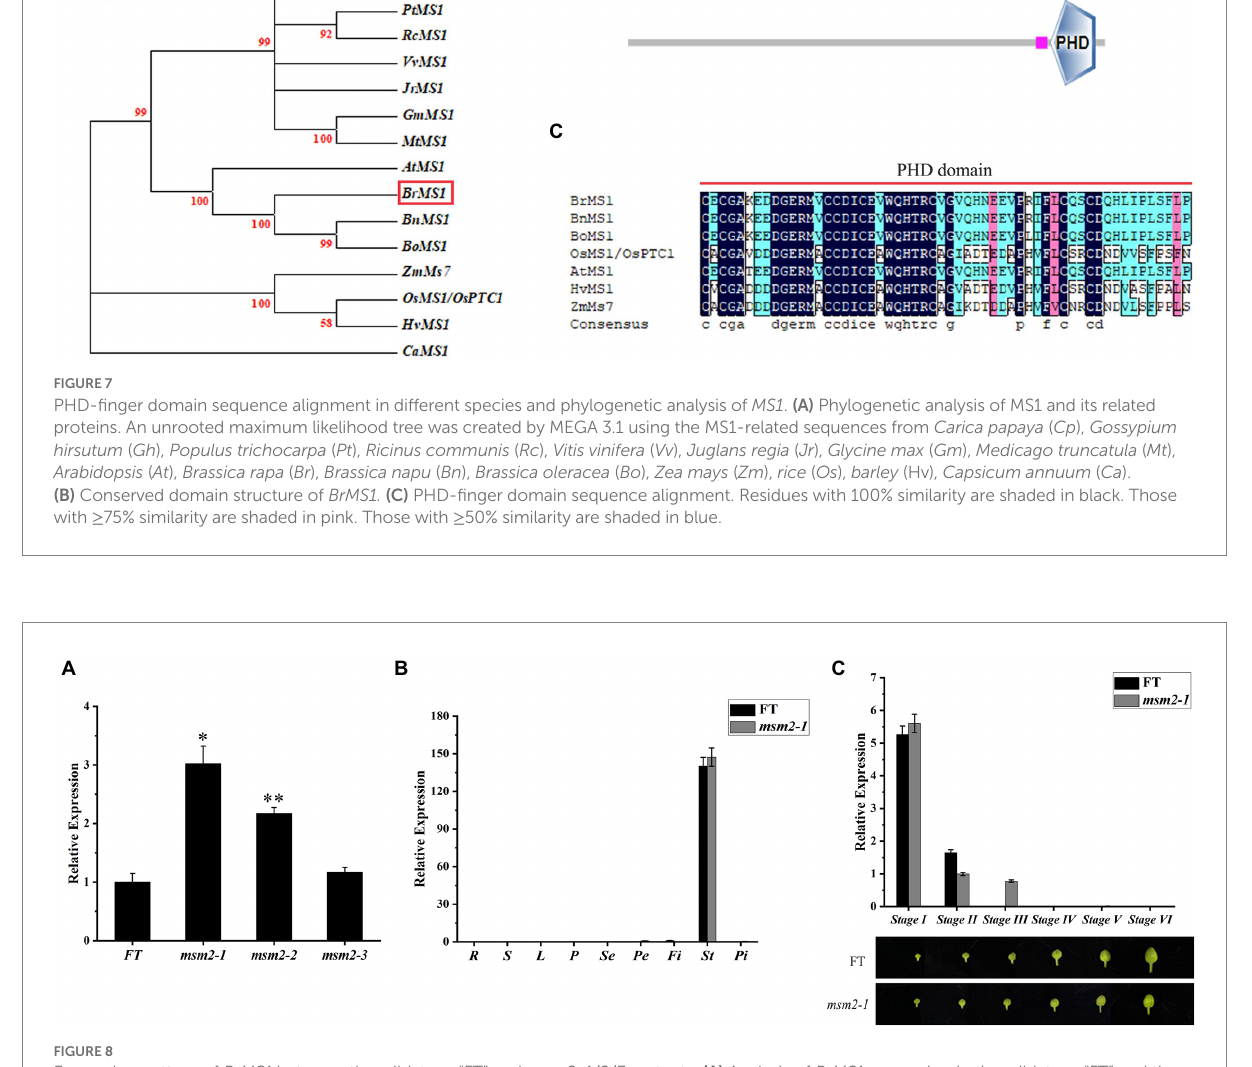
FIGURE 8 Expression pattern of BrMS1 between the wild-type “FT” and msm2-1/2/3 mutants. (A) Analysis of BrMS1 expression in the wild-type “FT” and the allelic mutants msm2-1/2/3. Asterisks indicate statistically significant differences determined using a t -test ( * p < 0.05; ** p < 0.01). (B) Expression of BrMS1 in the roots ( R ), stems ( S ), leaves ( L ), pods ( P ), sepal ( Se ), petal ( Pe ), filament ( Fi ), stamen ( St ) and pistil ( Pi ) of the wild-type “FT” and msm2-1 mutant. (C) Analysis of BrMS1 expression in different grades of buds in wild-type “FT” and msm2-1 mutant. The grading rules for flower buds are the same as those for paraffin